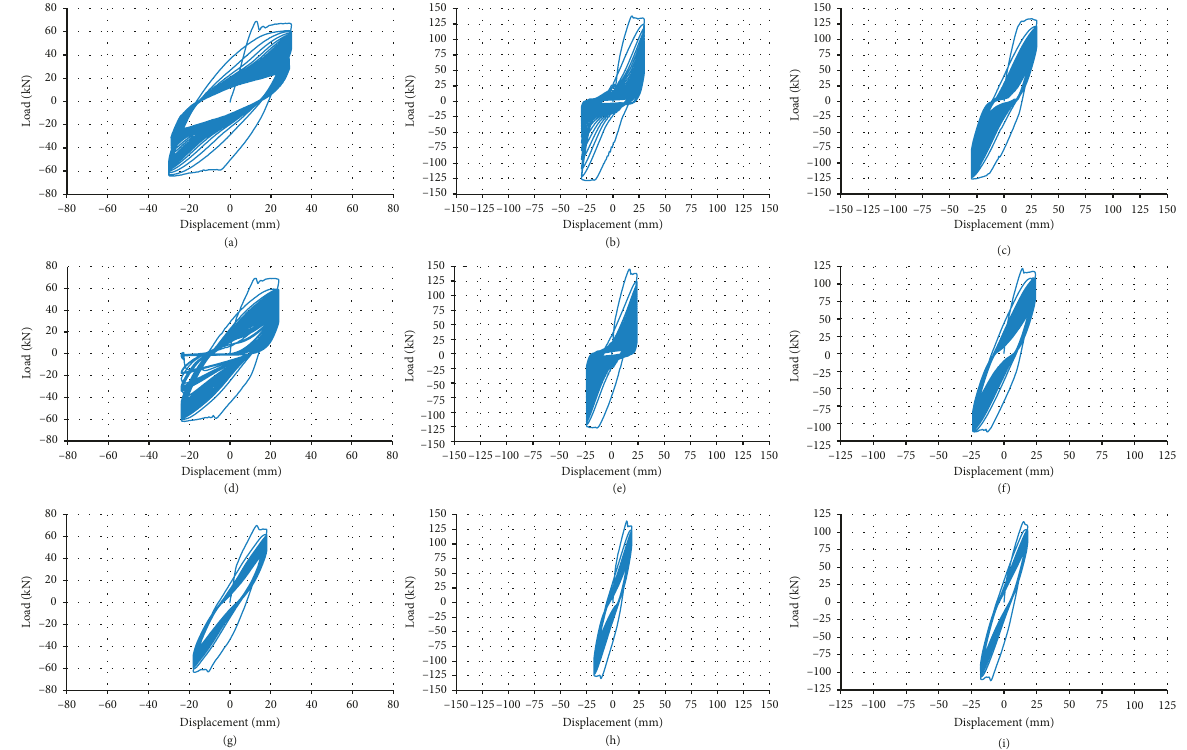
Figure 8: Typical hysteretic curves of some test members. (a) Z-1. (b) J-1. (c) M-2. (d) Z-4. (e) J-4. (f) M-4. (g) Z-7. (h) J-7. (i)